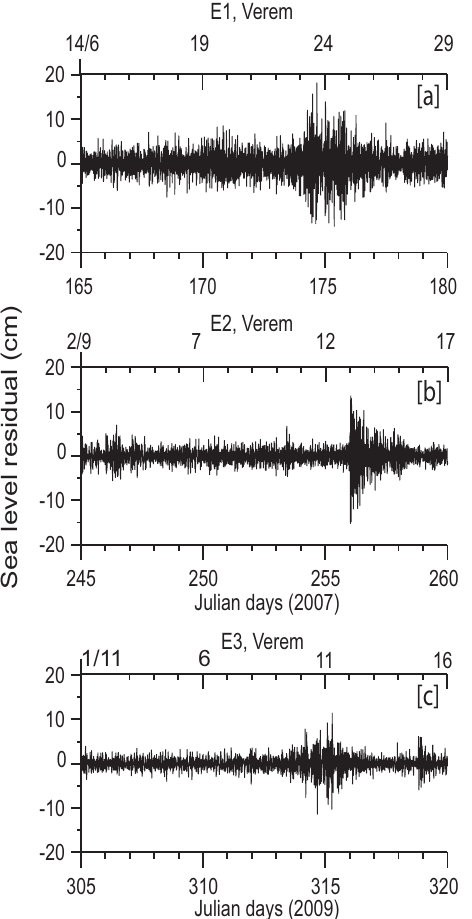
Fig. 5. Time-series of two-weeks long, high-pass filtered (pe- riod < 2h) sea-level residual at Verem during different episodic events (a) E1, (b) E2 and (c) E3. The X-axis represents Julian days of the respective year.